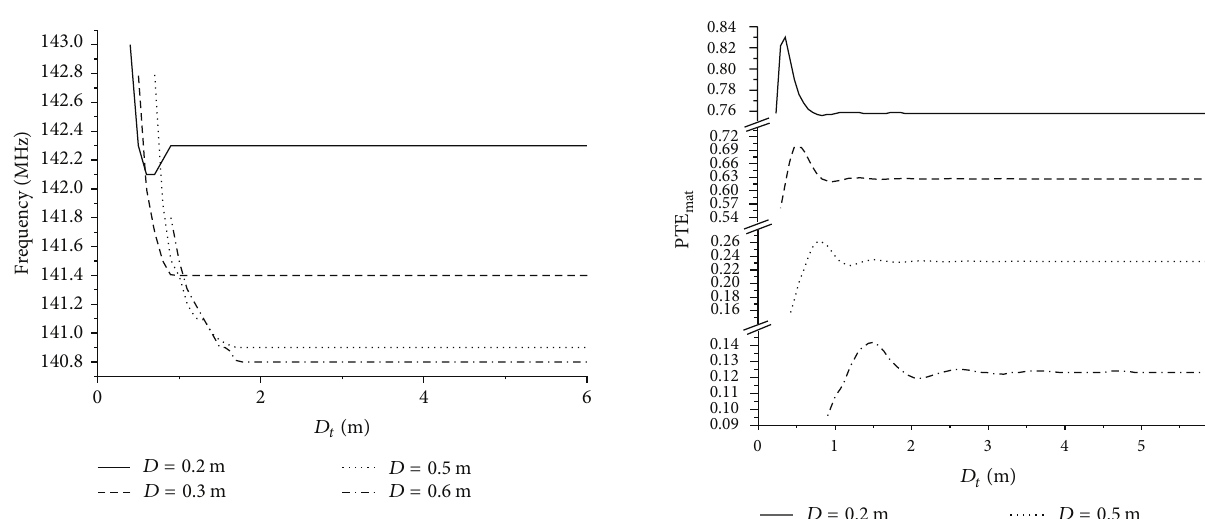
Figure 6: Operating frequency of PTE mat against 𝐷 𝑡 for different 𝐷 .